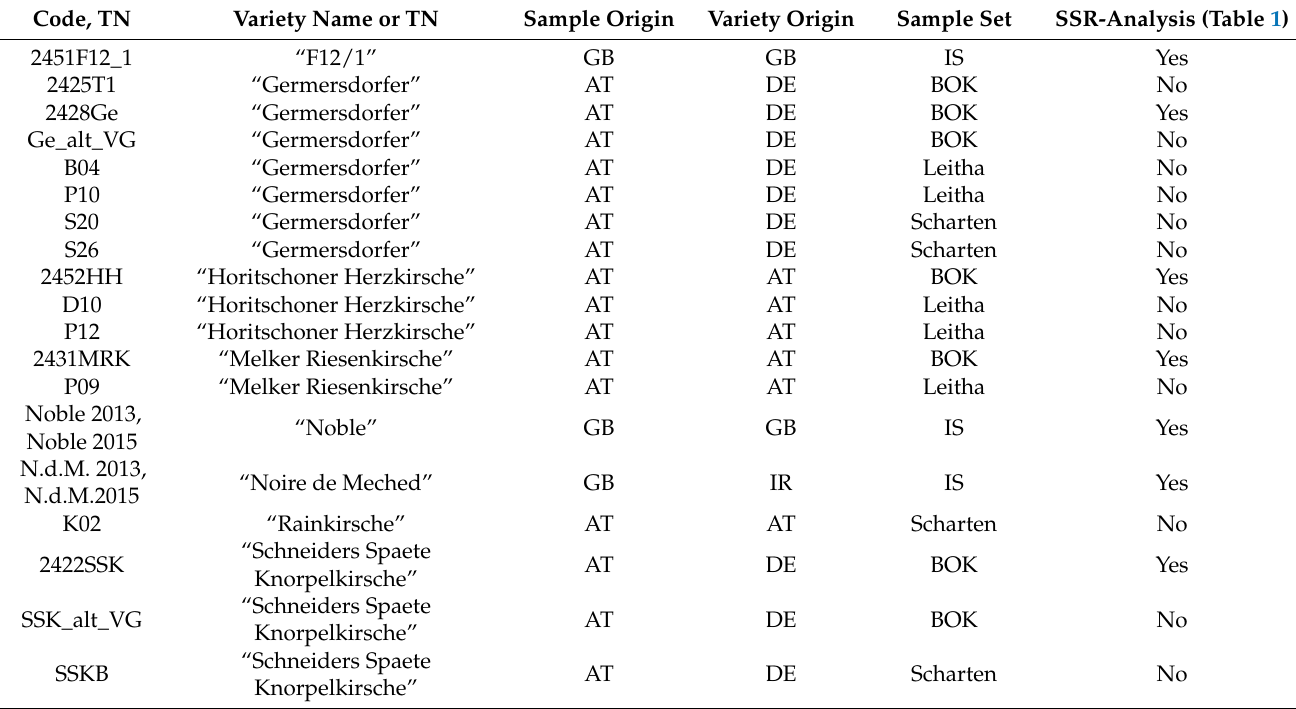
Table 2. List of accessions for AFLP-analysis listed by their variety name. Code, TN: identifies the individual tree in the respective sample set for AFLP-analysis. Sample Origin: Country-Code where the plant material was collected, Variety Origin: Country-Code where this variety originated; Sample Set: Accessions for AFLP-analysis belong to one of four sample sets: Leitha: Leithaberg, Scharten, BOK: BOKU, Vienna germplasm collection, IS: International Standards; The column "SSR-analysis (Table 1)” indicates if this tree has also been included in the SSR-analysis presented in this study.